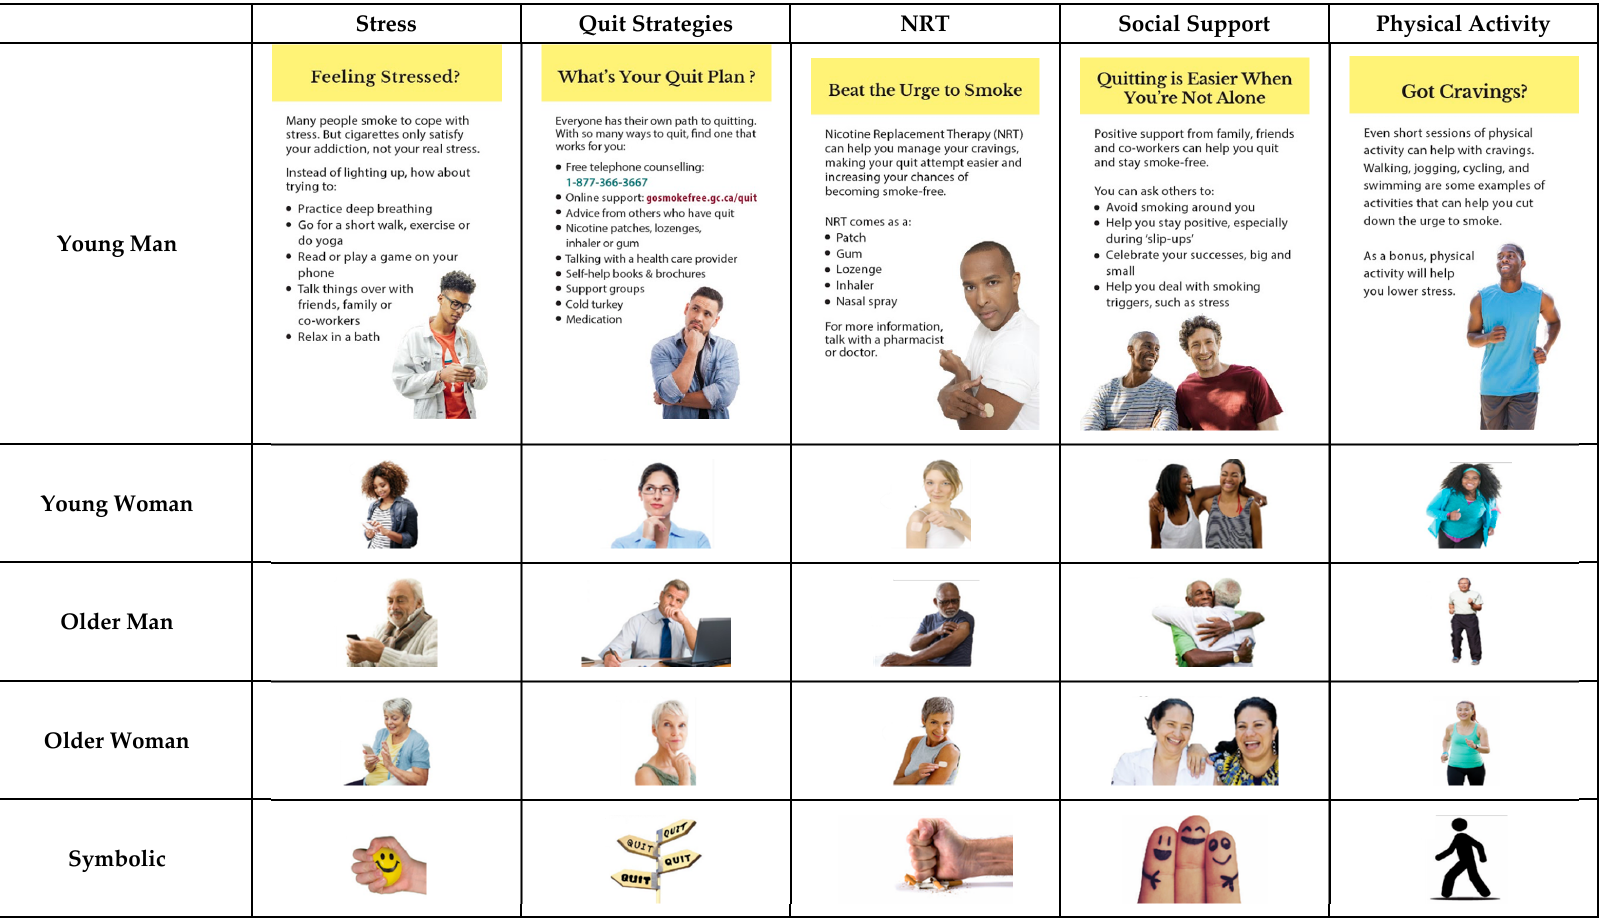
Figure 2. Topic and imagery for quitting tips messages in DCE 2.